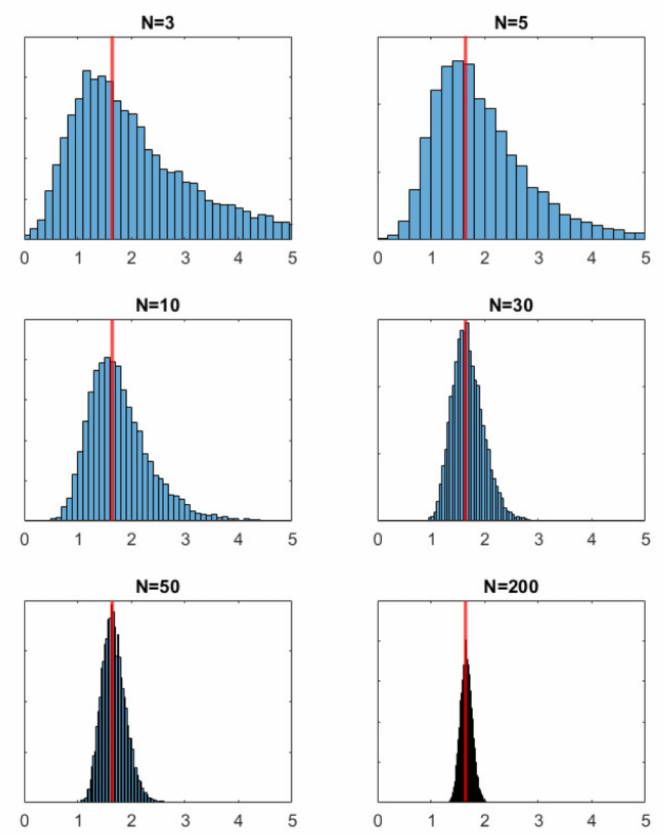
Figure A8. Noncentral